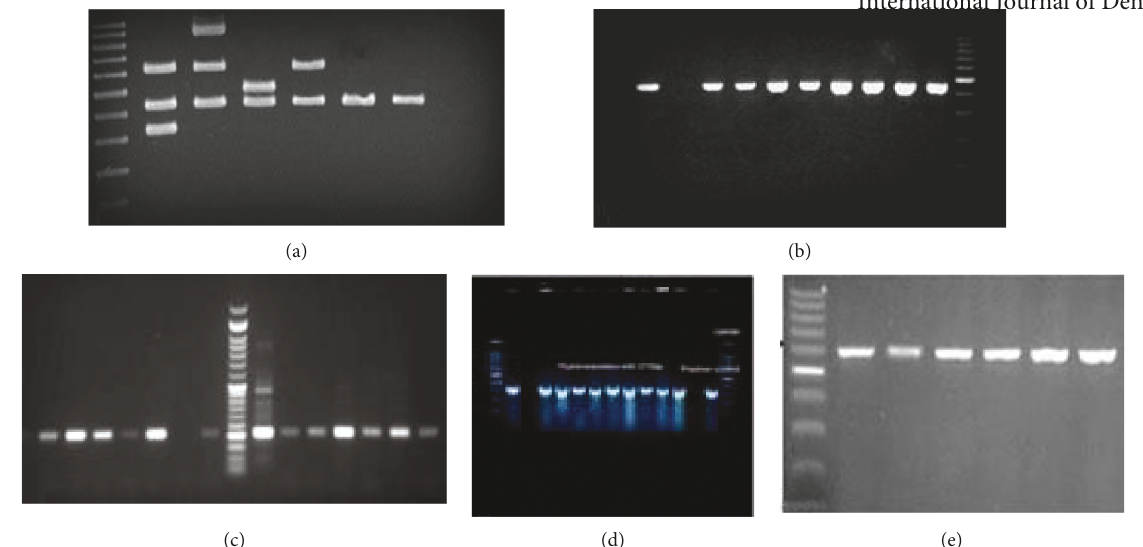
Figure 1: (a): Multiplex PCR amplification of patient isolated bacterial species. (b–e) PCR amplification of patients’ isolated: (b) Streptococcus mutans , (c) S. salivarius , (d) S. sanguinis , and (e) Lactobacillus